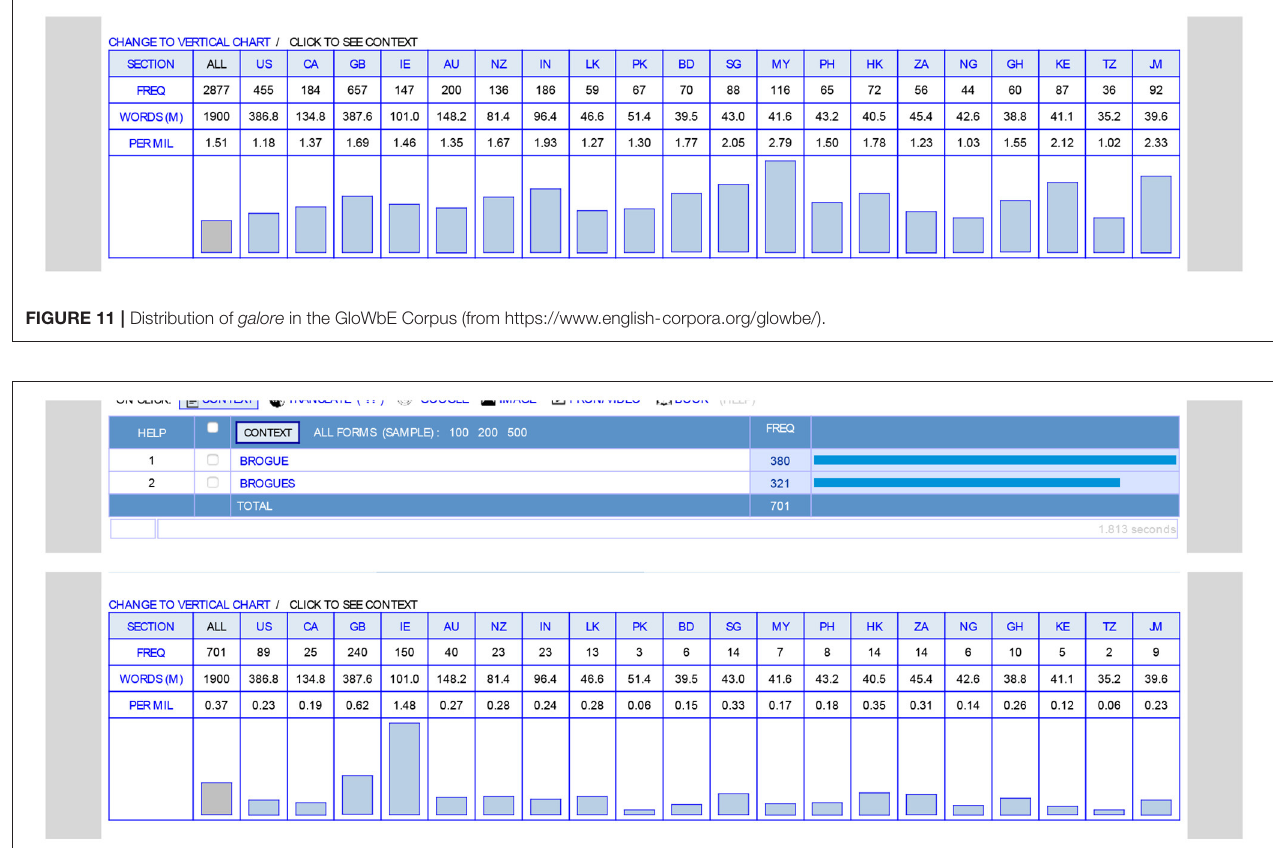
FIGURE 12 | Distribution of brogues in the GloWbE Corpus (from